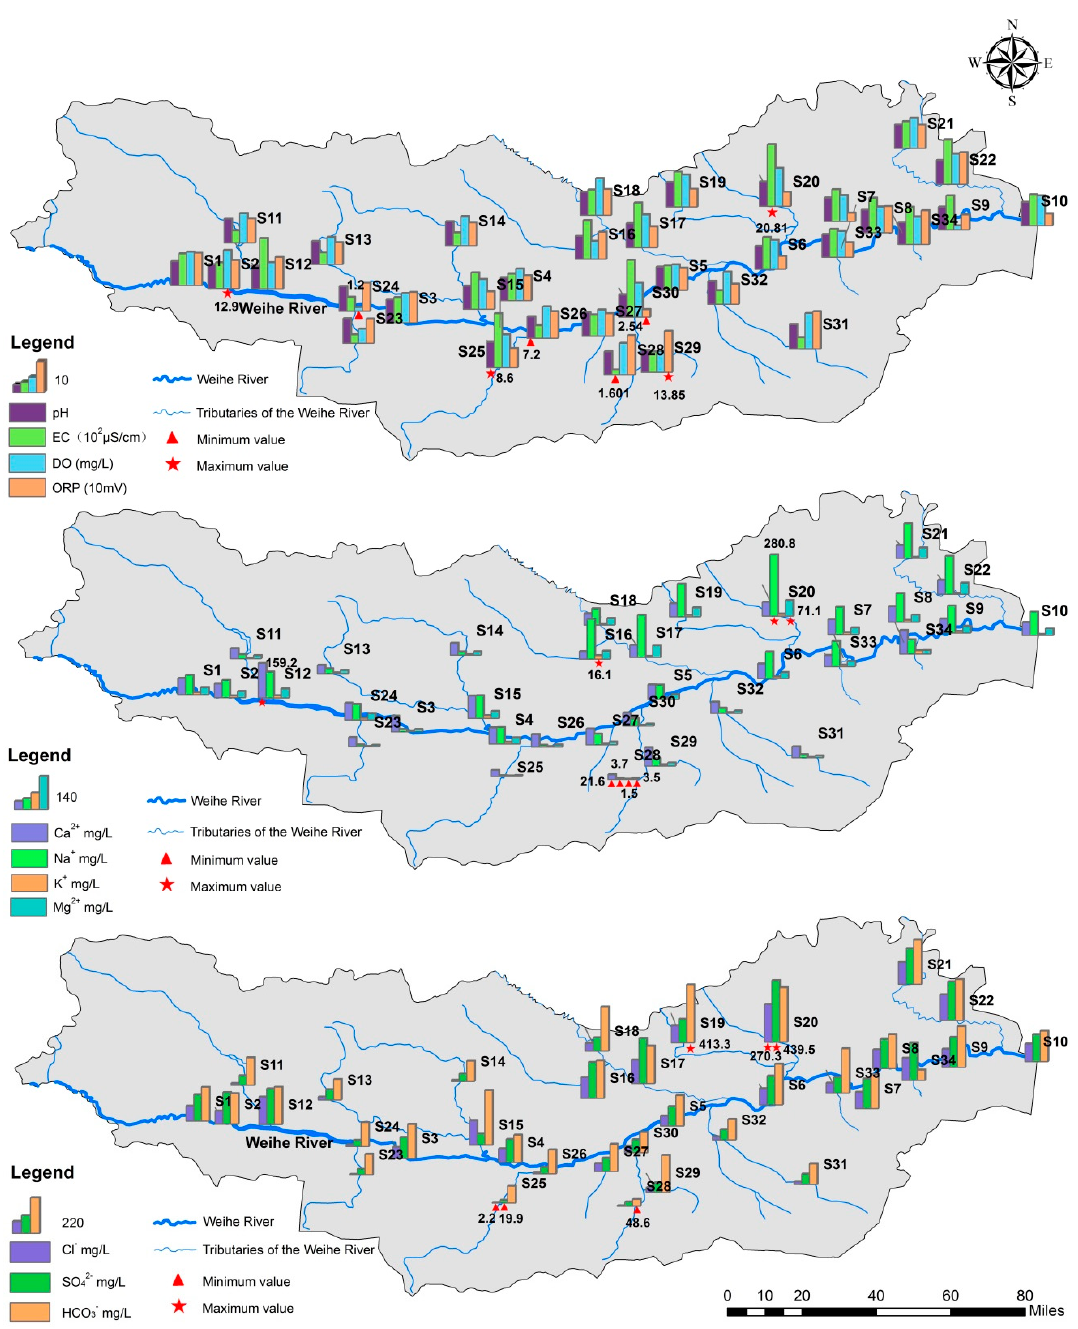
Figure 2. Analyses of chemical parameters in the study area.